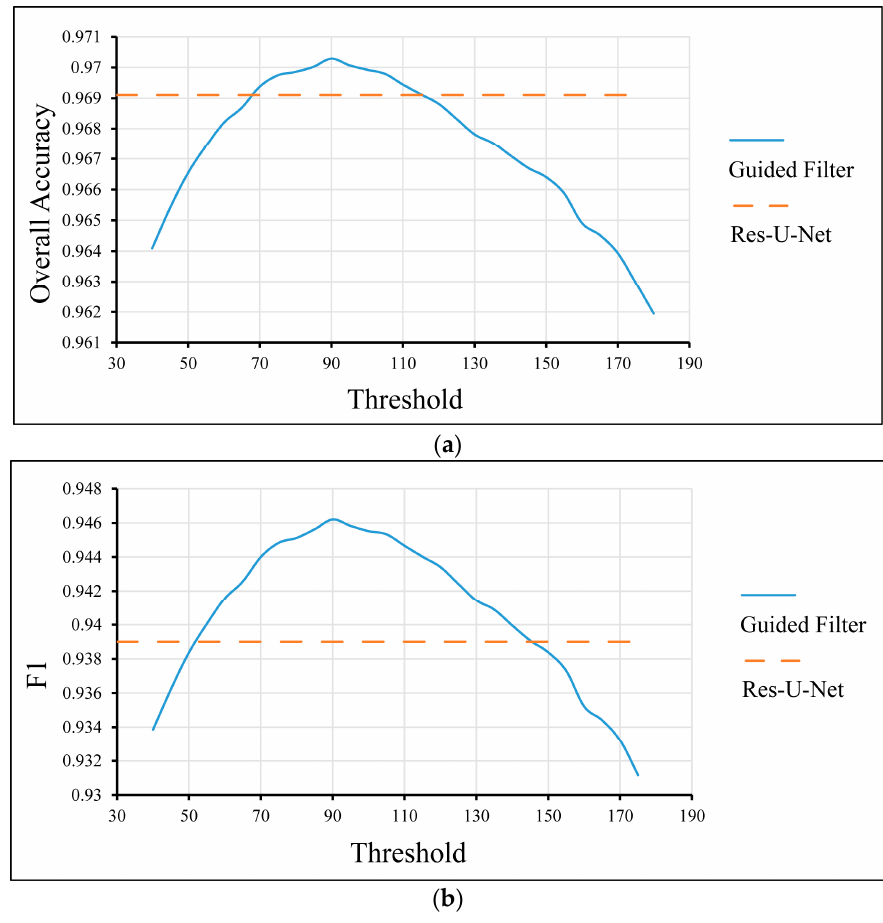
Figure 12. The overall accuracy ( a ) and F 1 ( b ) changing as the threshold increases while optimization by the guided filter.